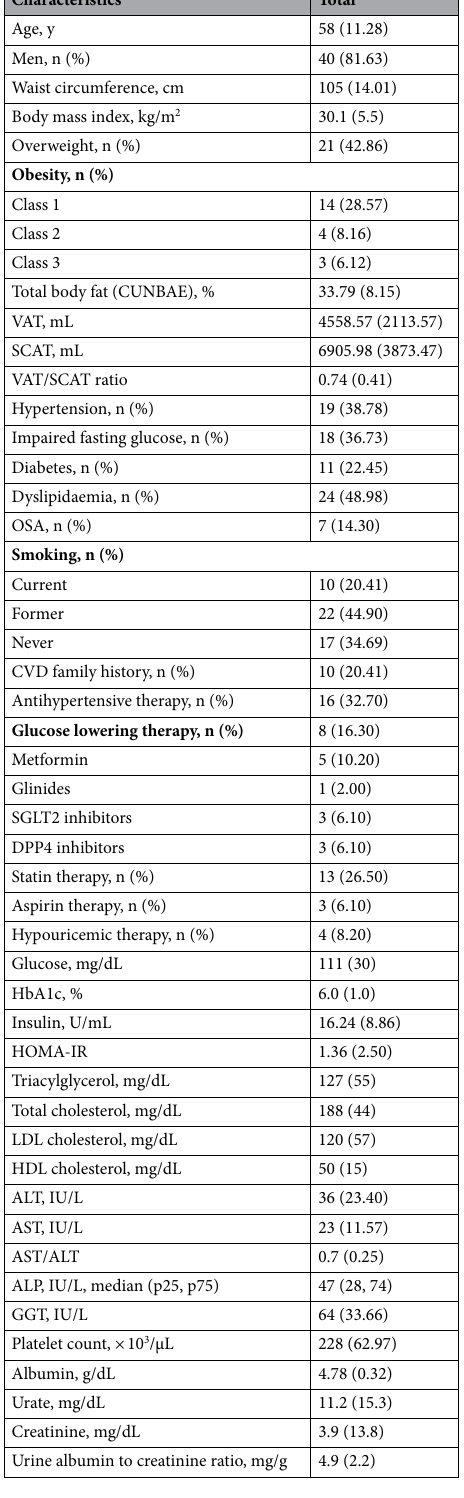
Table 1. Characteristics of non-alcoholic fatty liver disease patients (n = 49). Values are expressed as mean (SD), unless otherwise stated. ALT Alanine transaminase, ALP alkaline phosphatase, AST